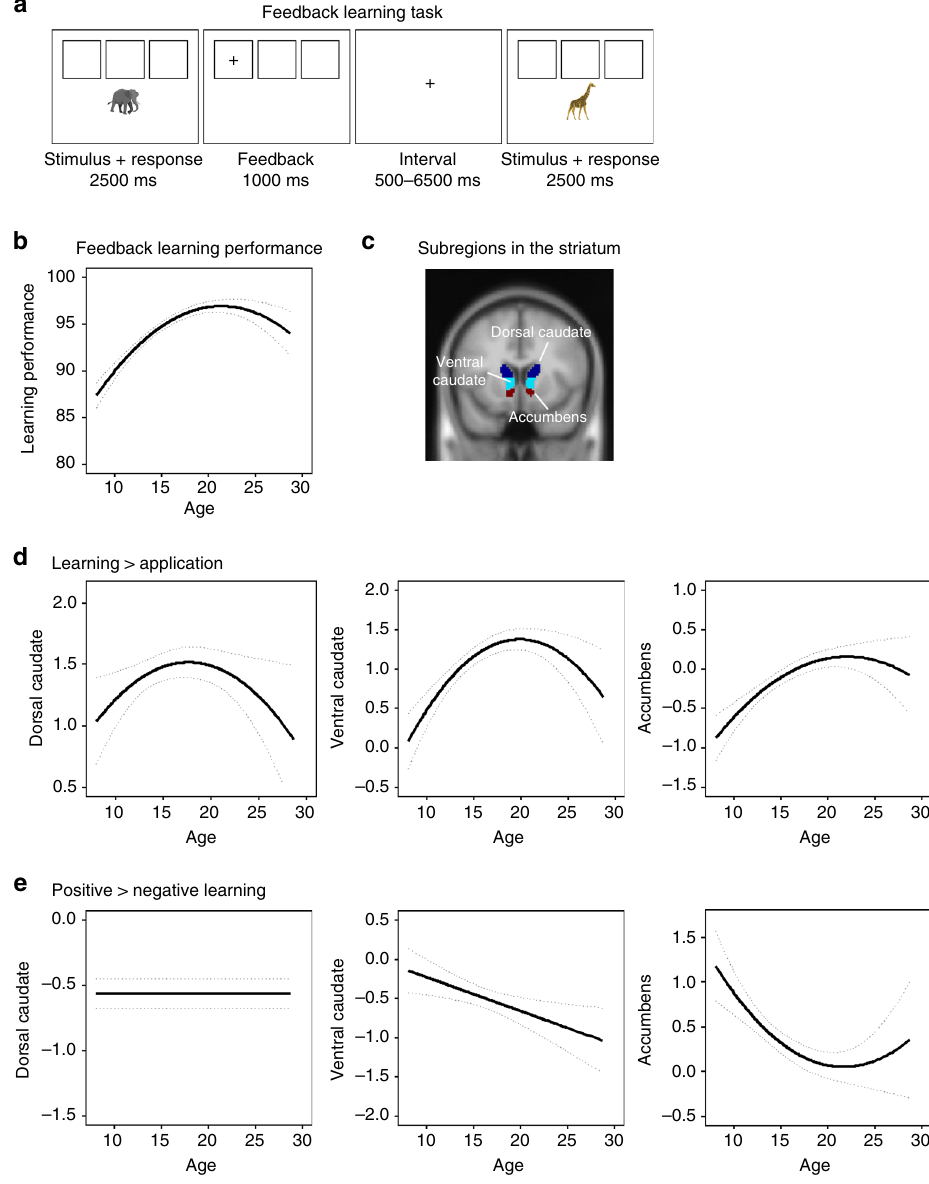
Fig. 1 Mixed-model analyses for development of striatal subregions. a Feedback-learning task, b predicted trajectories for feedback-learning performance (dotted lines represent 95% con fi dence intervals), c anatomical ROIs in striatal subregions (dark blue = dorsal caudate, light blue = ventral caudate, red = nucleus accumbens), d predicted trajectories for sensitivity to learning signals (contrast learning > application). A quadratic age effect was the best fi t for dorsal caudate (no age: Akaike Information Criterion (AIC) = 2337; linear: AIC = 2339, log-like p = 0.606; quadratic: AIC = 2335, log-like p = 0.020), ventral caudate (no age: AIC = 2370; linear: AIC = 2355, log-like p < 0.001; quadratic: AIC = 2339, log-like p < 0.001) and nucleus accumbens (no age: AIC = 2082; linear: AIC = 2056, log-like p < 0.001; quadratic: AIC = 2050, log-like p = 0.004). e Predicted trajectories for sensitivity to valence (contrast positive > negative learning). The best model for dorsal caudate revealed no age-related changes (no age: AIC = 2744; linear: AIC = 2746, log-like p = 0.662; quadratic: AIC = 2748, log-like p = 0.487), a linear age effect for ventral caudate (no age: AIC = 2826; linear: AIC = 2820, log-like p = 0.007; quadratic: AIC = 0.2819, log-like p = 0.082), and a quadratic age effect for nucleus accumbens (no age: AIC = 2536; linear: AIC = 2521, log-like p < 0.001; quadratic: AIC = 2516, log-like p = 0.013) ( N = 736